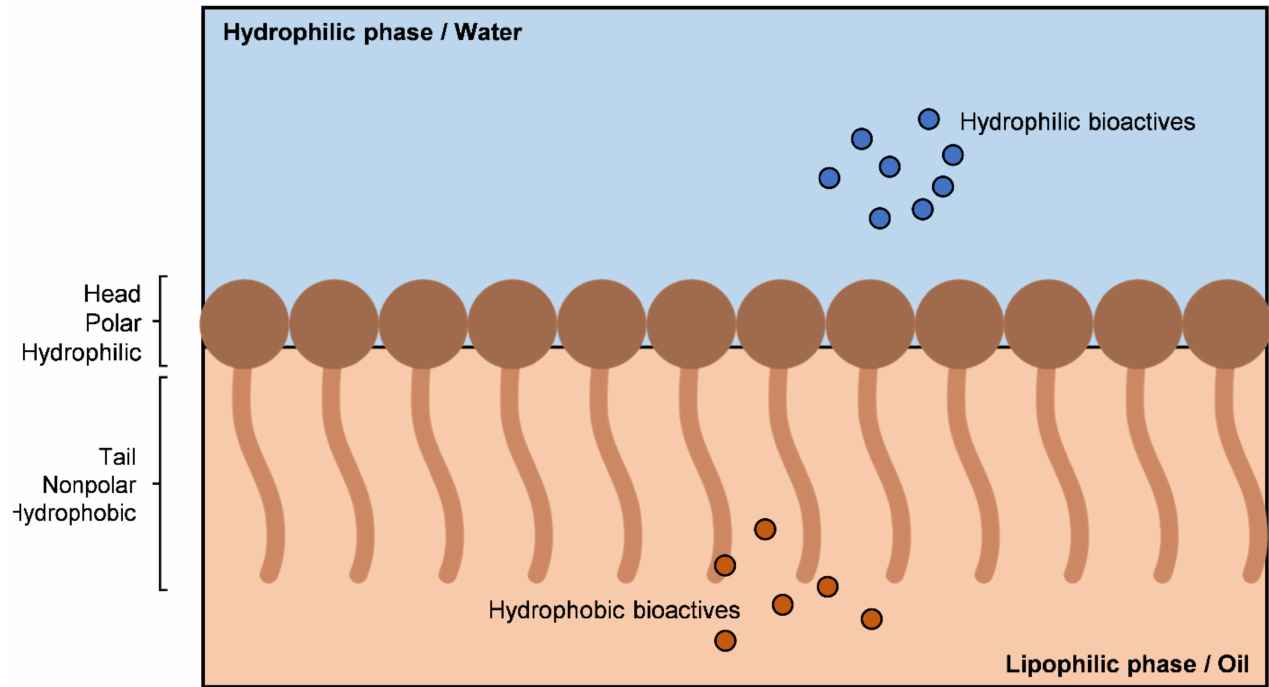
Figure 3. Schematic representation of surfactant placement in the oil/water